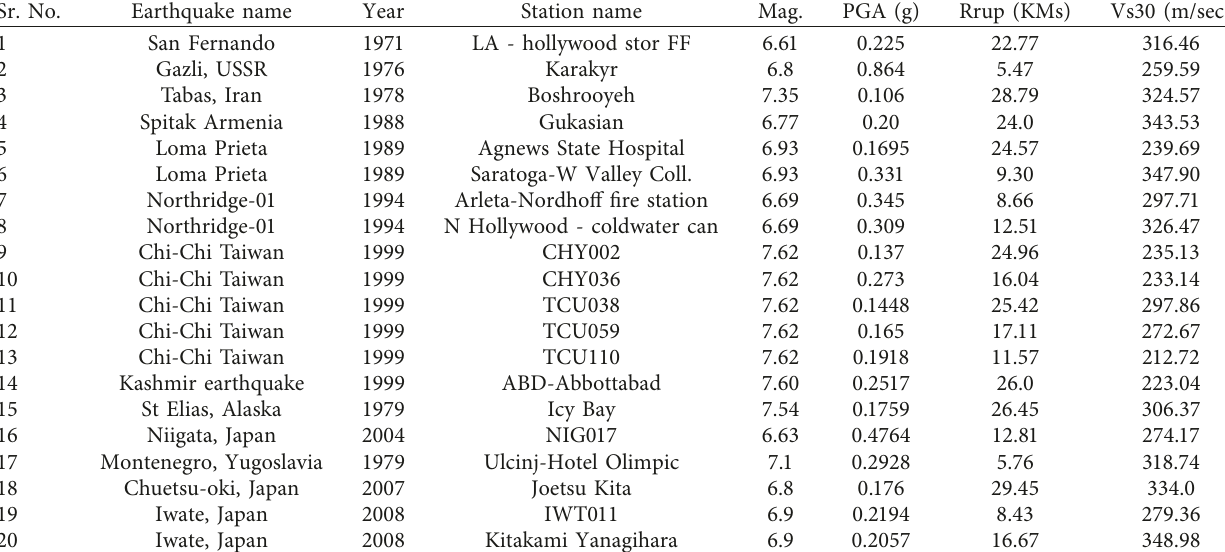
Table 4: Selected natural ground motions.